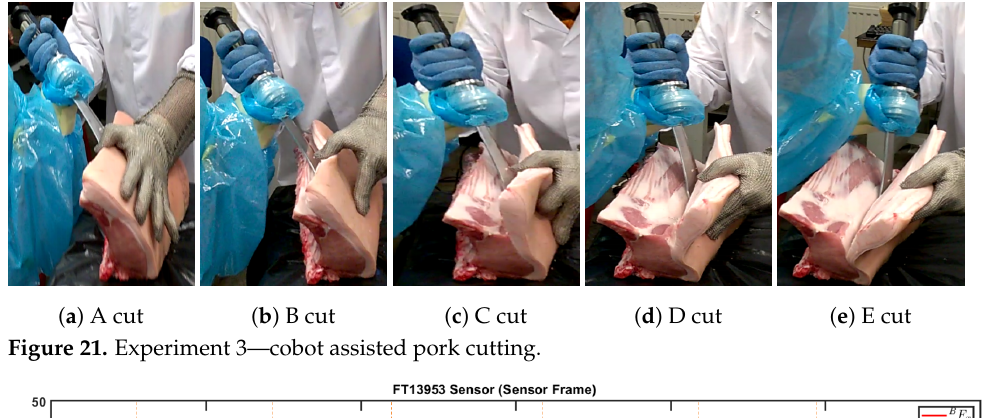
Figure 21. Experiment 3—cobot assisted pork cutting.